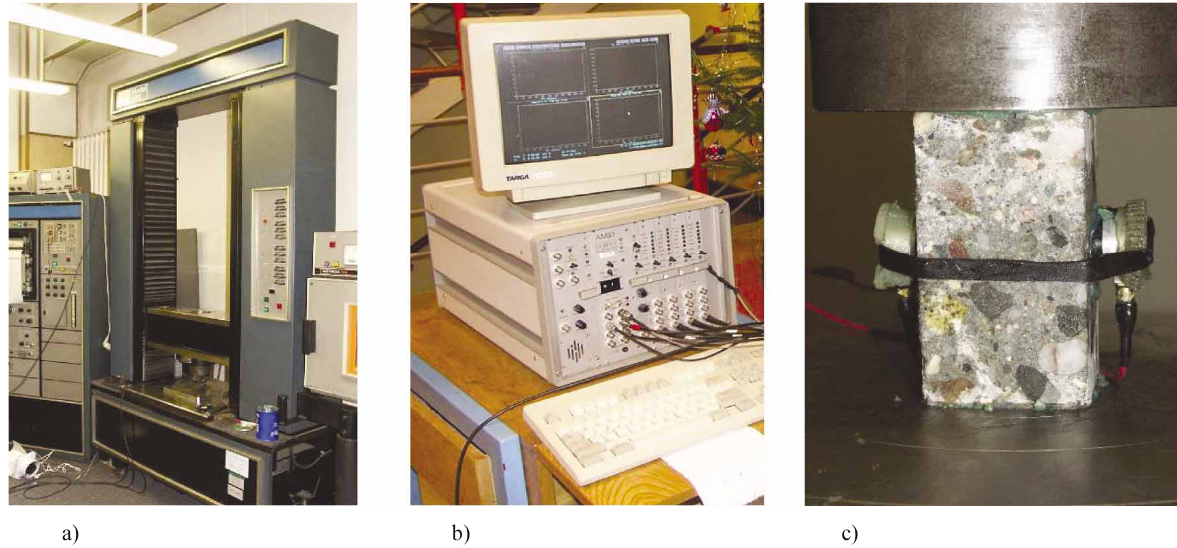
Fig. 3. Rig for measuring acoustic emission in compressed concrete: a) strength tester Instron 1126; b) measuring set Vallen-Systeme Gmbh AMS3; c) concrete specimen prepared for